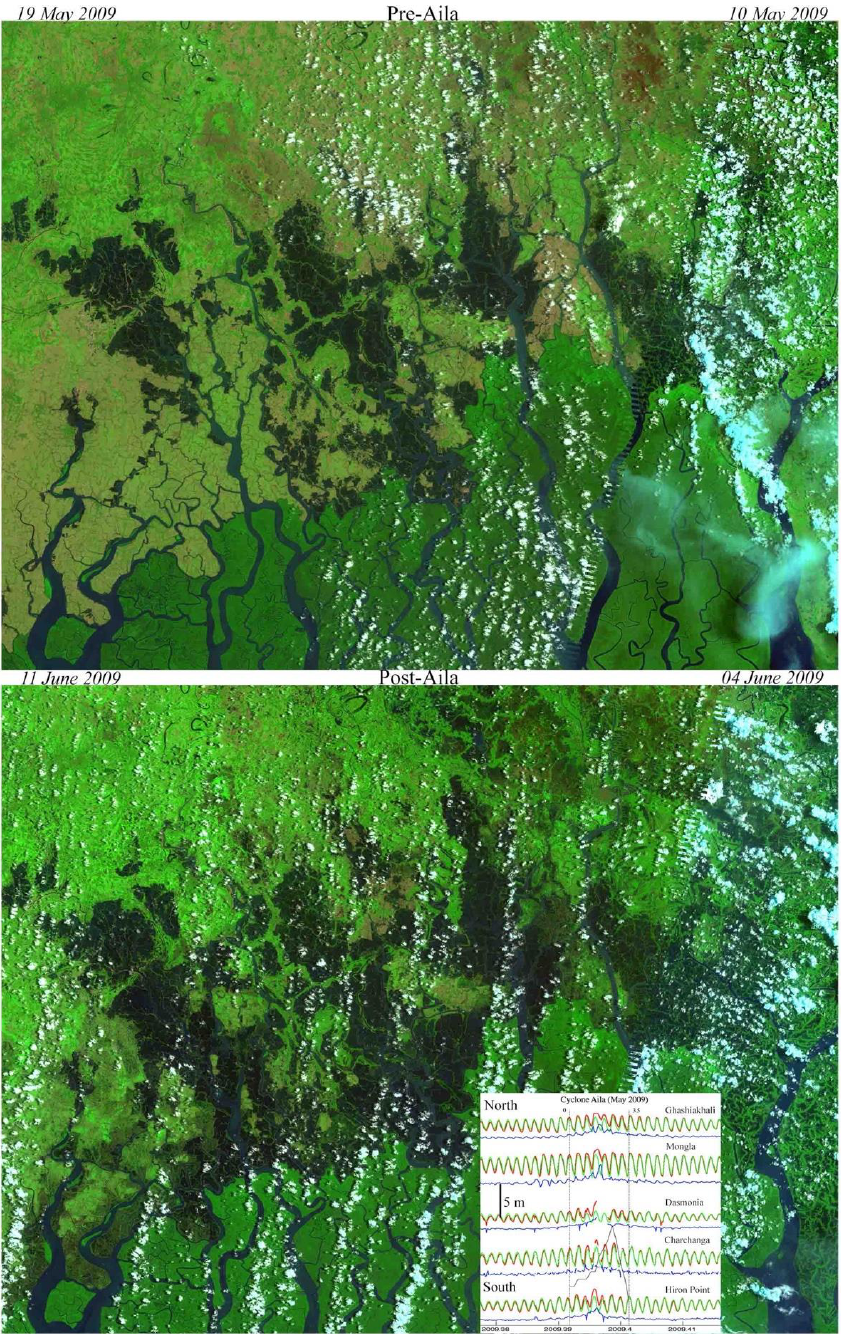
Figure 8. Flooding and soil saturation shortly before and after Cyclone Aila made landfall in West Bengal on 25 May 2009. Landsat composites show increased area of inundation as black and saturated soils as dark green/brown. Inset shows water levels (red), modeled tides (green), and storm surge residual (blue) at nearby tide gauges from Chiu and Small (2016). Both images are false color composites: red = SWIR reflectance; green = NIR reflectance; blue = visible reflectance (TM bands 6, 4, and 2).